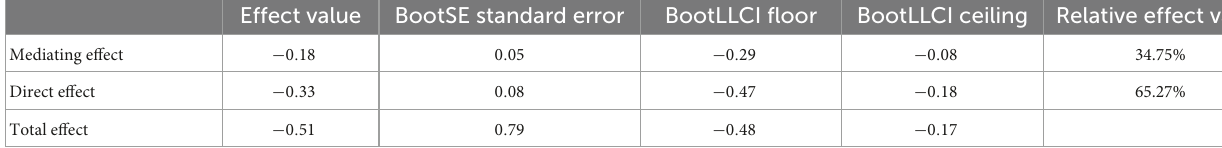
TABLE 6 Breakdown table of total effect, direct effect, and mediating effect.